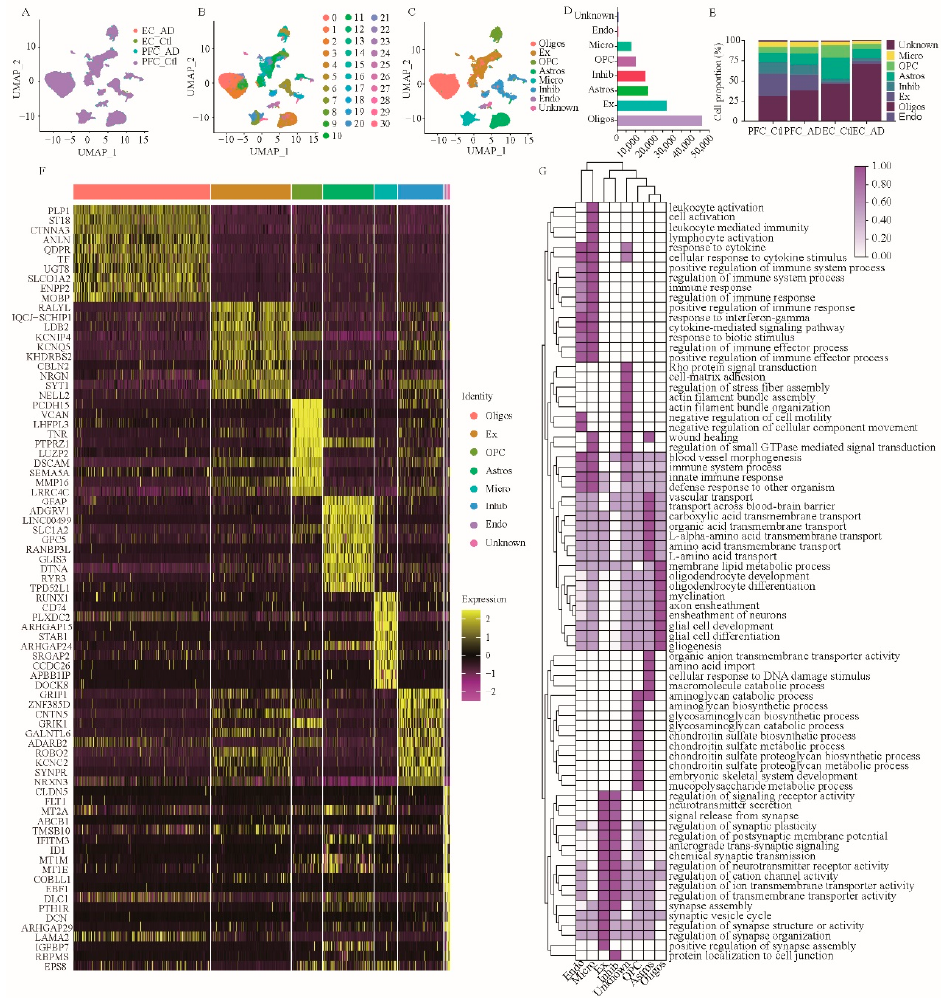
Figure 1. SnRNA-seq analysis of prefrontal and entorhinal cortex of AD patients. ( A – C ) Unbiased identification of cell type heterogeneity in human prefrontal and entorhinal cortex. PFC: prefrontal cortex; EC: entorhinal cortex; AD: Alzheimer’s disease; Ctl: Control. A, UMAP plot showing data integration of 3 datasets, 4 groups. B, UMAP plot showing 31 cell clusters obtained after data ensemble cluster analysis. C, UMAP map of seven cell types. ( D ) Number of individual cell types in 124,658 nuclei. ( E ) Cell percentage of the seven cell types in different groups. ( F ) Heatmap of top 10 DEGs in 8 cell types. ( G ) GSEA of cell type-specific DEGs. Oligos: oligodendrocytes; Ex: excitatory neurons; OPC: oligodendrocyte precursor cells; Astros: astrocytes; Micro: microglia; Inhibi: inhibitory neurons; Endo: endothelial cells; GSEA, gene set enrichment analysis.